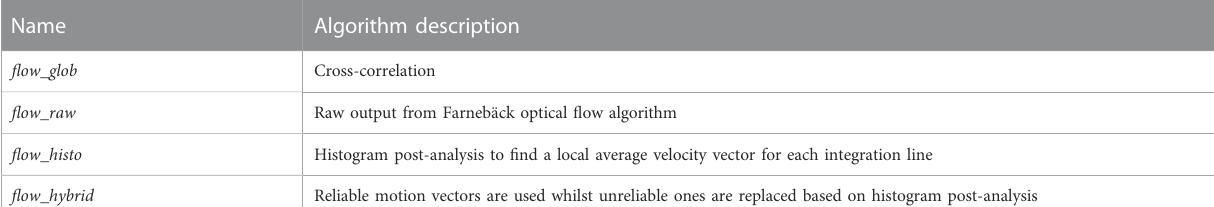
TABLE 2 Plume speed estimation algorithms, based on Gliß et al.